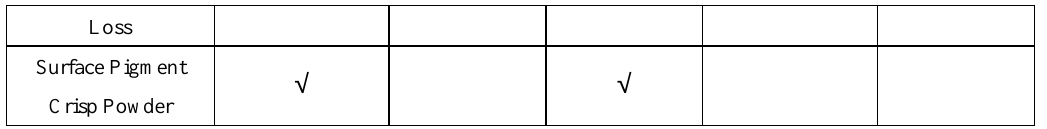
Table 2 Stone monument disease survey